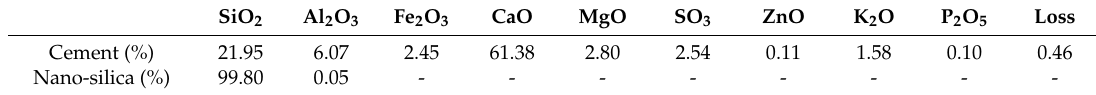
Table 1. Chemical compositions of cement and nano-silica.